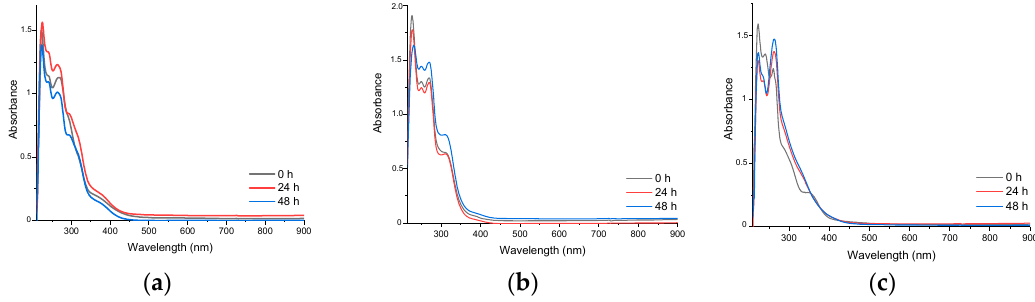
Figure 6. Time-dependent stability studies on complexes: ( a ) 1 ; ( b ) 2 and ( c ) 3 in Tris-HCl/NaCl buffer solution monitored by UV–Vis absorption spectra.